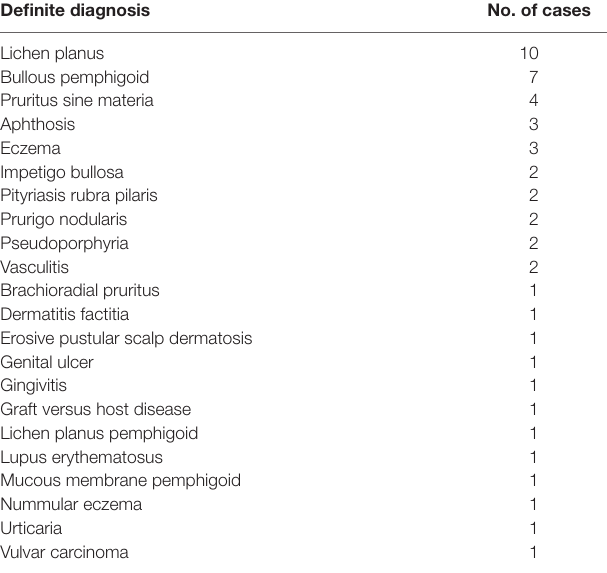
TaBle 1 | Final diagnoses of patients in the direct immunofluorescence negative group. Definite diagnosis